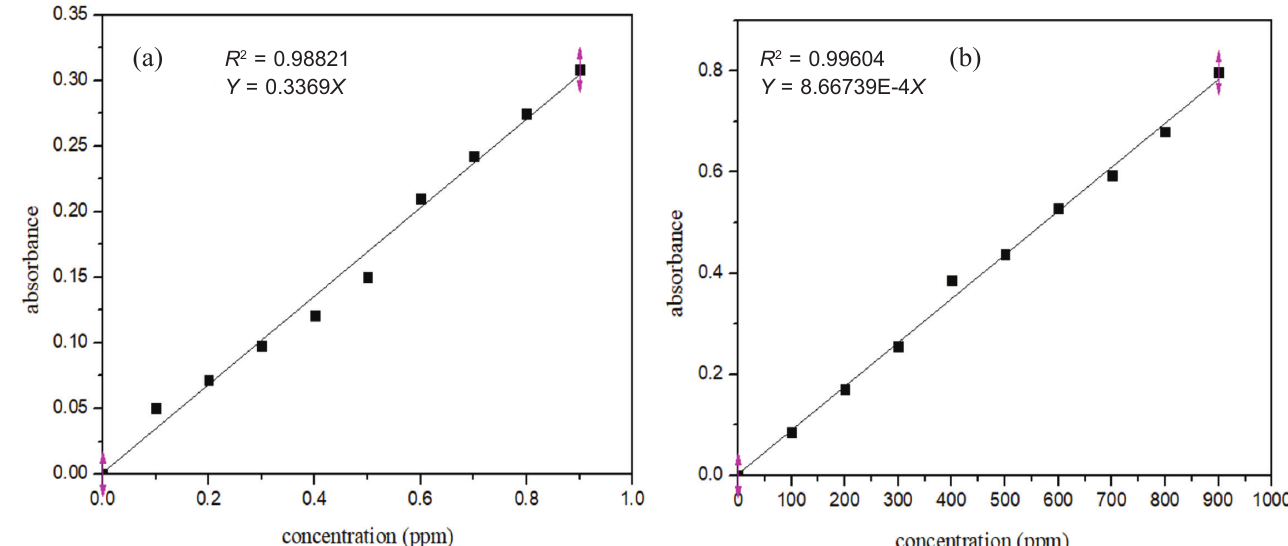
Fig. 5 – Calibration curve of As(III) (a) and Cu(II)